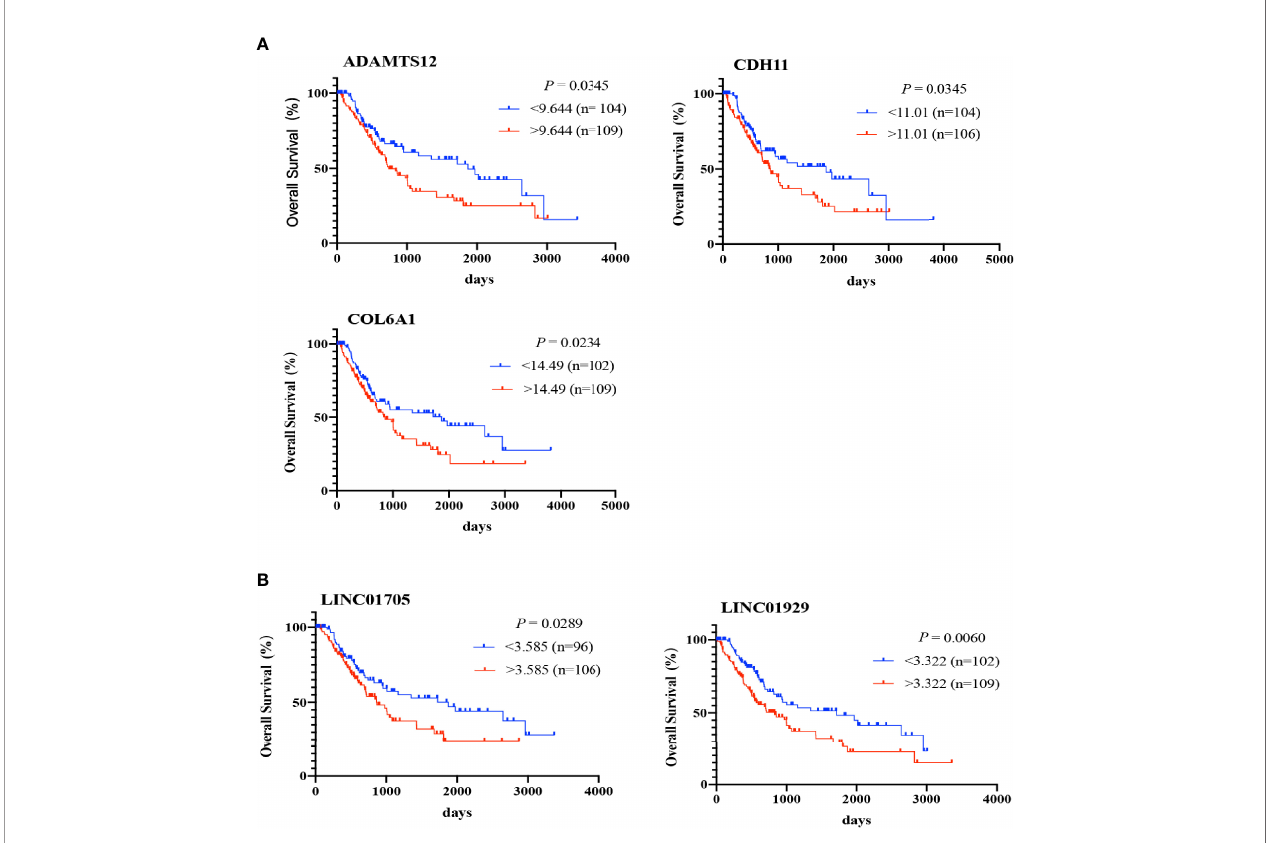
FIGURE 4 | Survival analysis performed for 8 core lncRNAs and 28 core mRNAs. The Kaplan-Meier curve shows the percent survival rate for BCa patients based on RNA expression in BCa tissue samples. The P-value is calculated using the log-rank test (p < 0.05) (A, B)